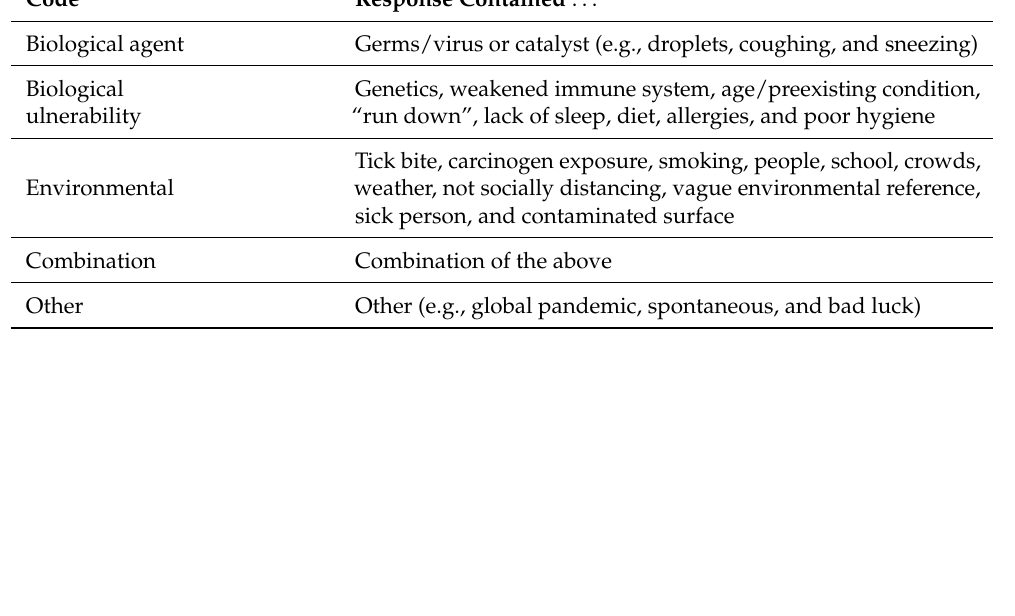
Table A1. Q3 (Causation) “Why do you think (X) got sick? Are there any other reasons?”.